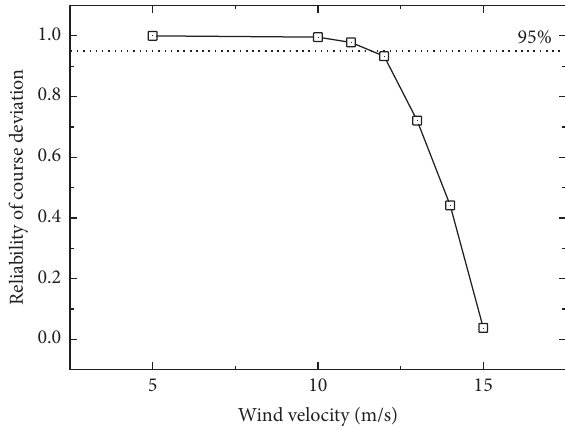
Figure 7: Reliability with wind velocity (course